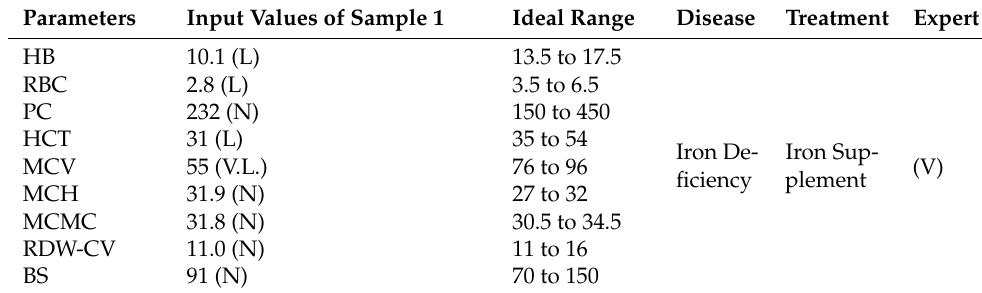
Table 5. Sample 3 and its outcome.